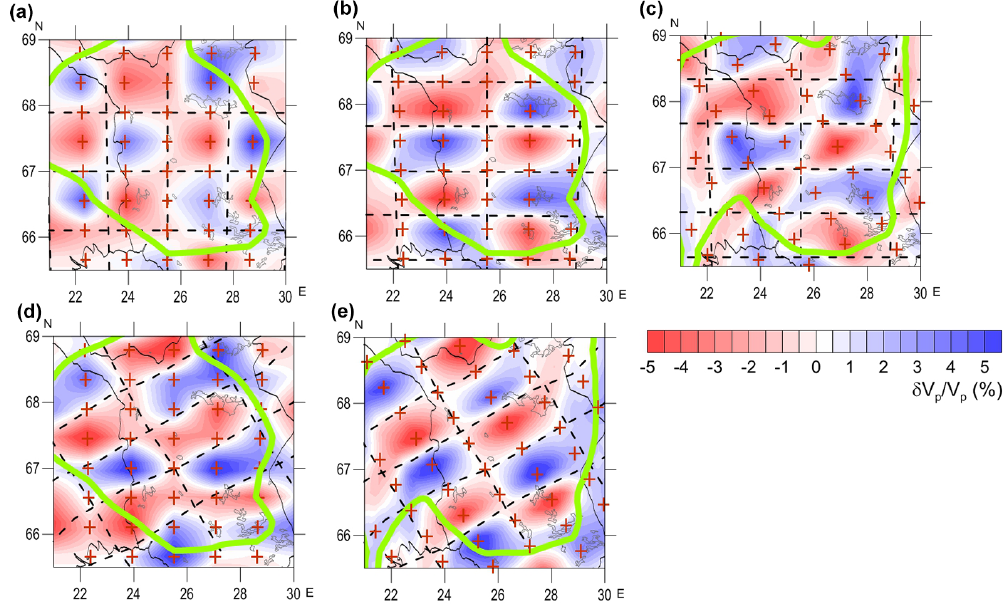
Figure 8. Results of the checkerboard test for normal orientation of synthetic anomalies and normal grid with different sizes of synthetic anomalies: (a) 100 × 100km, (b) 150 × 75km. Subplots (c) , (d) and (e) show results of testing for size 150 × 75km. (c) Orientation of synthetic anomalies is normal (W–E oriented), the inversion grid is rotated to an angle of 30 ◦ anticlockwise from the north, (d) synthetic anomalies are rotated, orientation of the inversion grid is normal, (e) both synthetic anomalies and the grid are rotated. Horizontal cross sections of the reconstructed pattern are shown for the depth of 10km. The dotted lines are the boundaries of synthetic anomalies with different velocity in testing model. Green contours restrict the area with a resolution of more than 0.5. Brown crosses denote locations of the parameterisation nodes for the inversion grid.